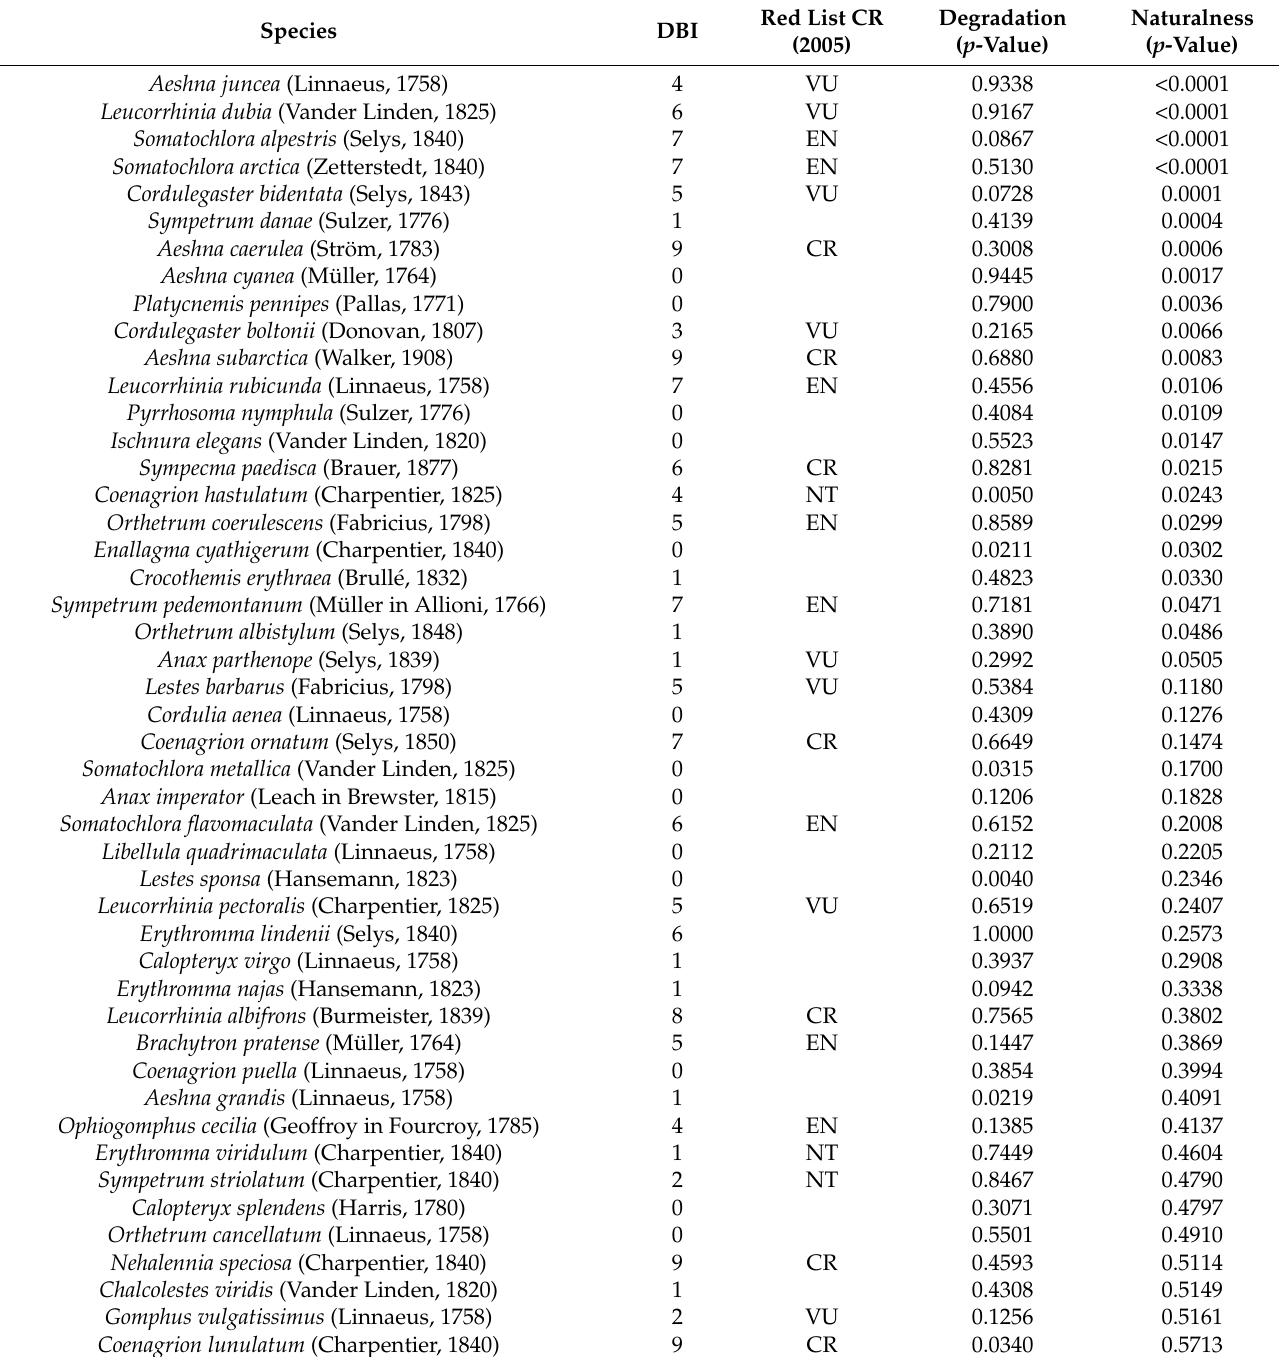
Table 1. Information on the Dragonfly Biotic Index (DBI) value, the degree of endangerment for the observed period, and the dependence on degradation and naturalness were assessed using Fisher’s test for the individual species of odonates from the Czech Republic (CR) included in the study. Species are sorted according to the dependency rate on naturalness. Red List Species DBI